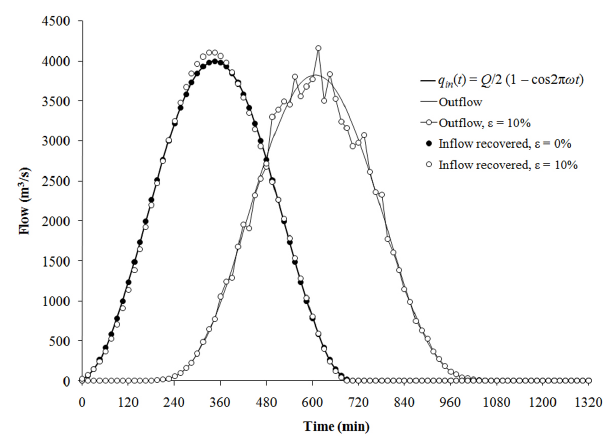
Fig. 11. Reverse routing of the sinusoidal inflow hydrograph of Bruen and Dooge